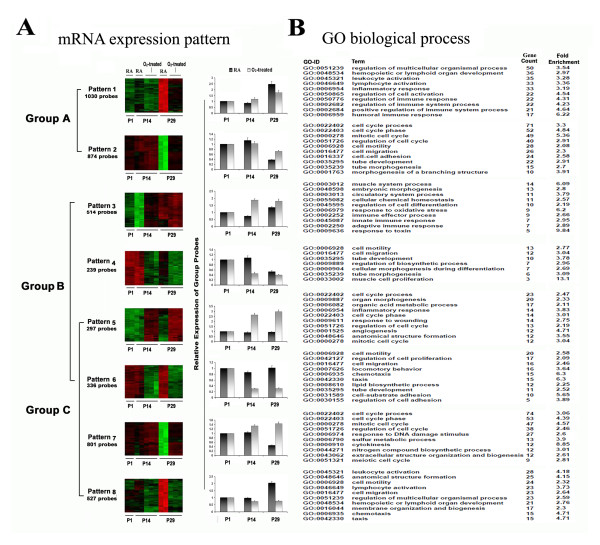
Expression patterns of hyperoxia-responsive mRNAs and functional analysis. Total RNA was isolated and RNA quality was confirmed. In total, 12 samples were used for analysis of mRNA expression; 2 samples for each normoxia group at time points of P1, P14, and P29; and 3 samples for each hyperoxia-treated group at time points P14 and P29. Gene expression profiling was performed using the Affymetrix GeneChip Mouse Genome 430 2.0 Array. Expression patterns of hyperoxia-responsive mRNAs and corresponding gene ontology mapping were performed. (A) 8 expression patterns in 3 groups represented by color heat maps and bar graphs (x axis indicating the 3 time points, y axis indicating the relative expression value of group probes). Red represents increased expression and green represents decreased expression in the depicted heat maps. The relative expression values in each time point are the ratios normalized against those in the P1 group. Group A: P29-RA vs P14-RA, Group B: P14-O2- treated vs P14-RA, Group C: P29-O2-treated vs P29-RA (B) Analysis of enrichment for GO biological process categories for 8 expression patterns. Top 10 GO terms (ranked by count number) with p < 0.05 are listed.